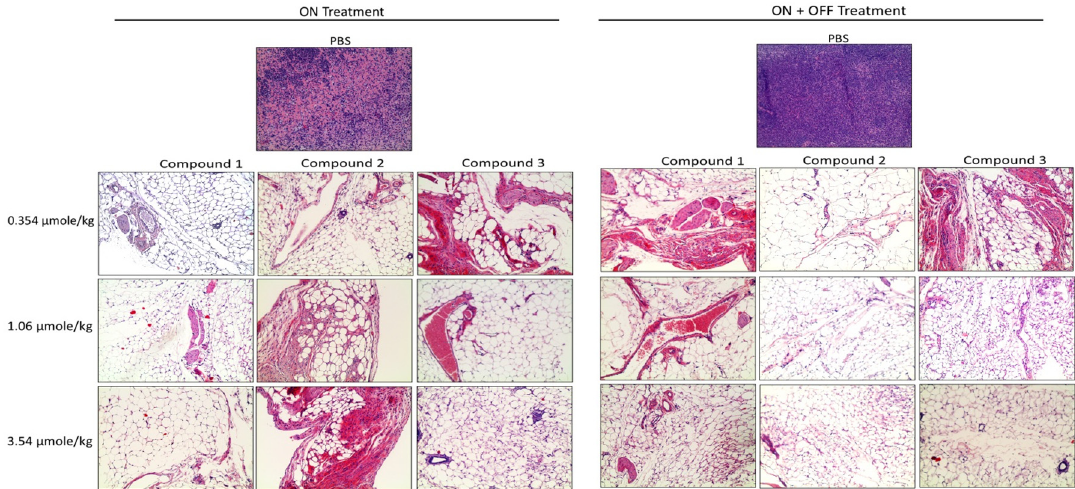
Figure 8. Histopathological images of H&E staining of glioblastoma xenografts in nude mice treated with Compounds 1 , 2 , and 3 . The scale bar is 10×. Complete infiltration with the malignant cells ~100% was observed in the controls. In the treatment groups, necrosis, and hyalinization > 90% were observed.